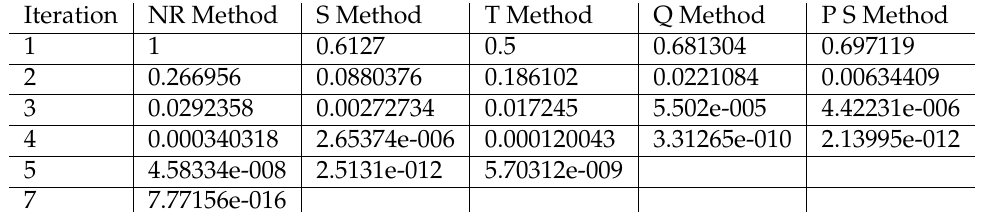
Table 6. Error analysis of NR Method, S Method, T Method, Q Method and P S Method for the Equation